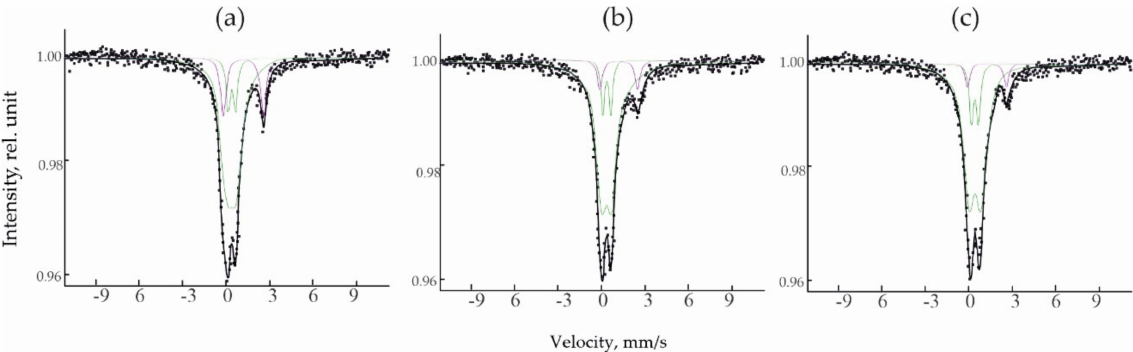
Figure 8. Results of the fitting of the Mössbauer spectra of initial ( a ), 1 month − treated ( b ), and 3 month − treated ( c ) bentonite samples. Doublets from Fe 3+ are represented by a green line, while from Fe 2+ by a red line.